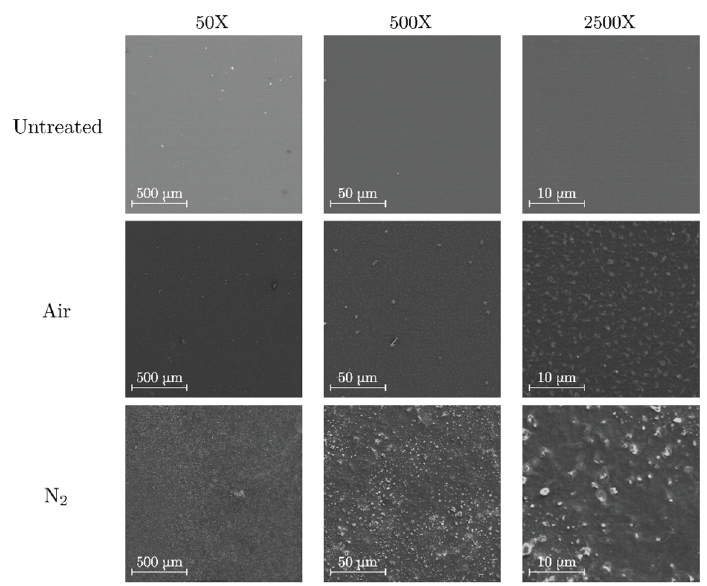
Figure 4. SEM images of untreated ( top ), air-treated ( center ) and nitrogen-treated ( bottom ) polymethyl methacrylate (PMMA).